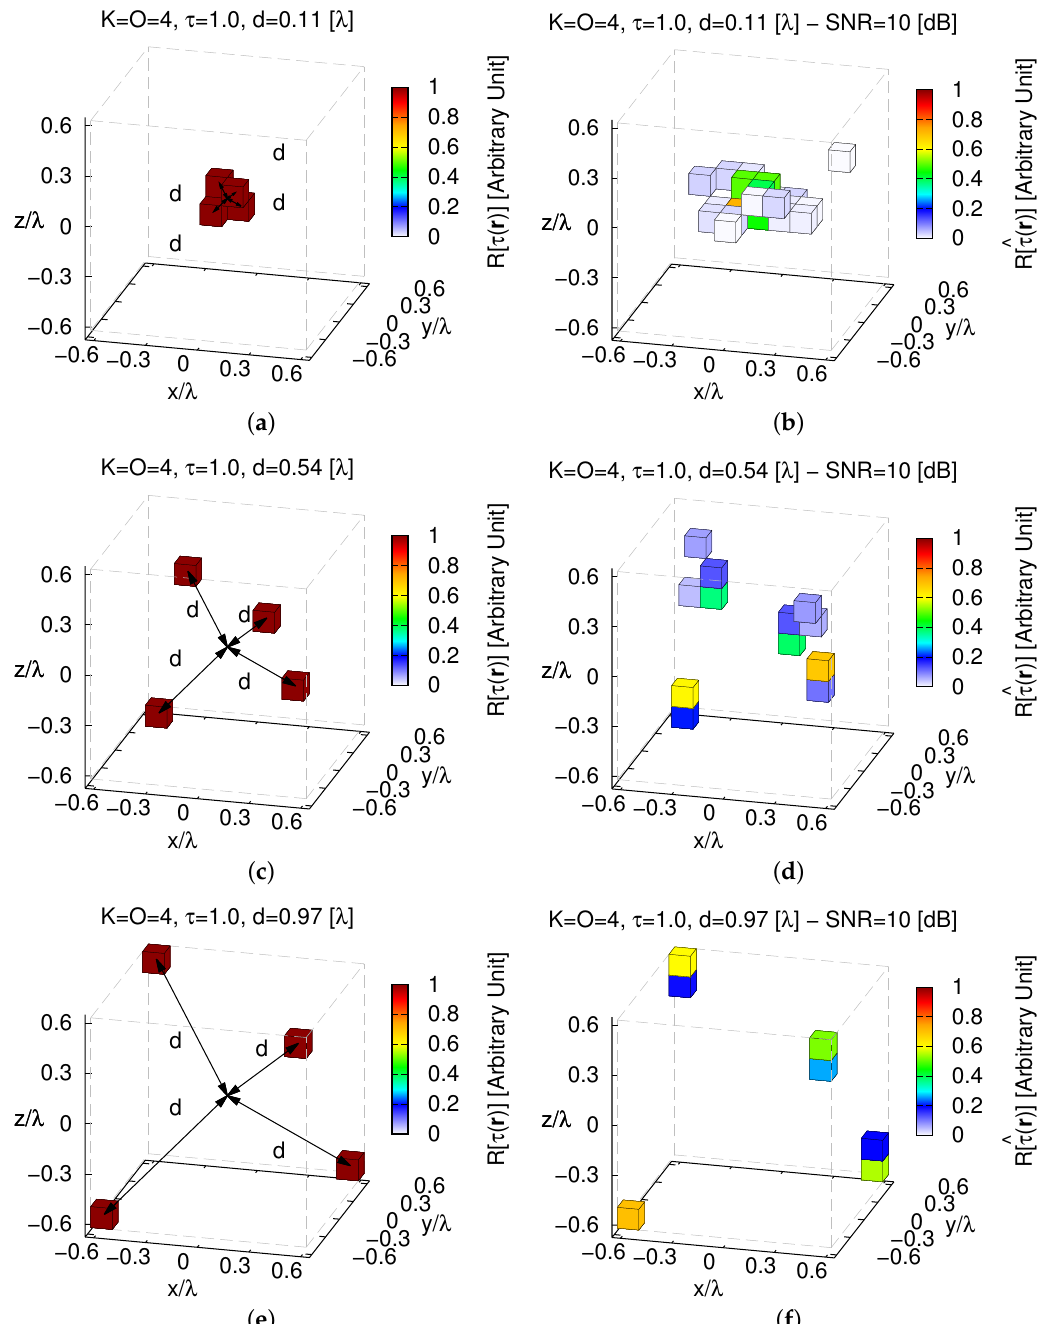
Figure 11. Numerical Assessment ( K = 4, O = 4, τ = 1.0, SNR = 10 [dB])—( a , c , e ) Actual contrast function and ( b , d , f ) MT-BCS reconstructions when the objects distance from the origin is ( a , b ) d = d min = 0.11 [ λ ] ( (cid:98) τ max = 0.73), ( c , d ) d = 0.54 [ λ ] ( (cid:98) τ max = 0.70), and ( e , f ) d = d max = 0.97 [ λ ] ( (cid:98) τ max =